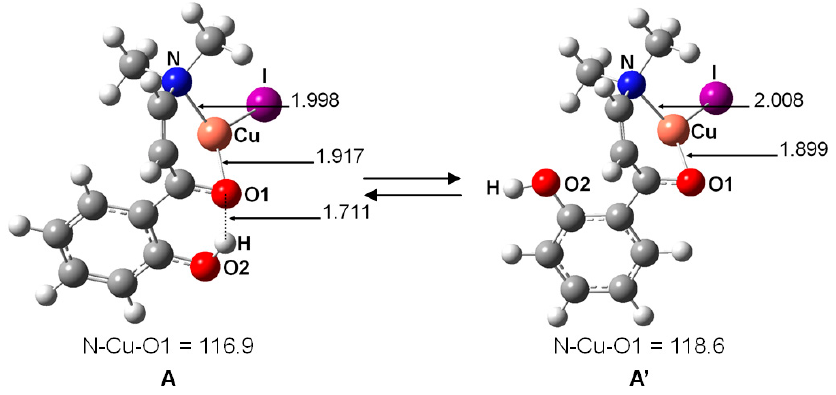
Figure 1. Optimized structures for LCuI complexes (bond lengths in Å).